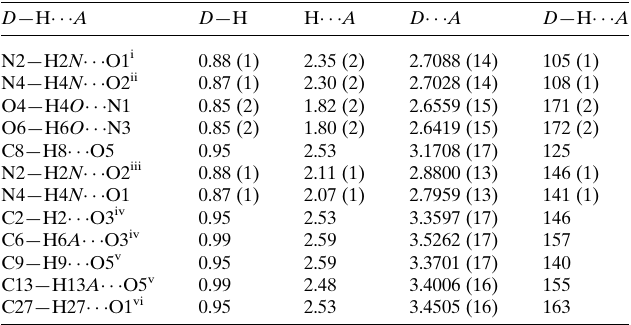
Table 1 Hydrogen-bond geometry (A˚ , (cid:3) ).